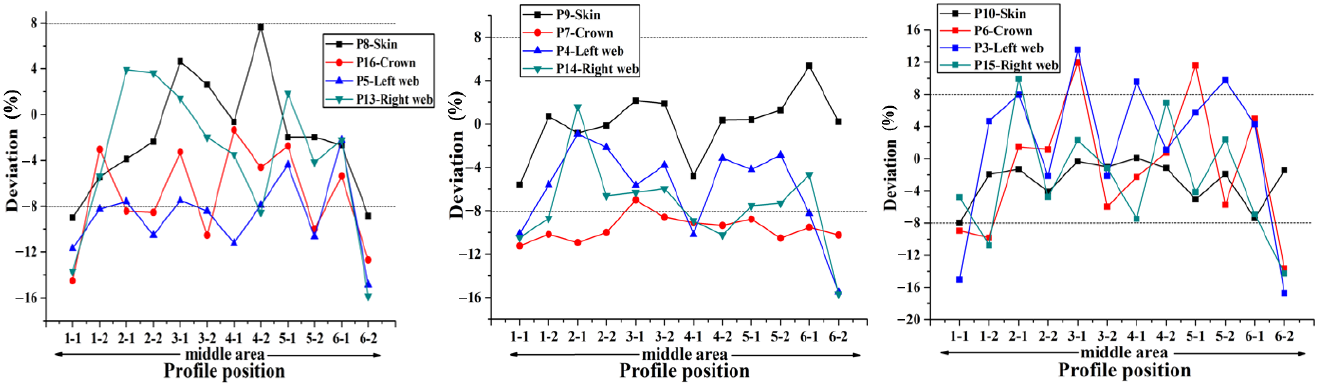
Figure 12. Comparison of dimensional stability of stringer manufactured by 50 HD bladder.